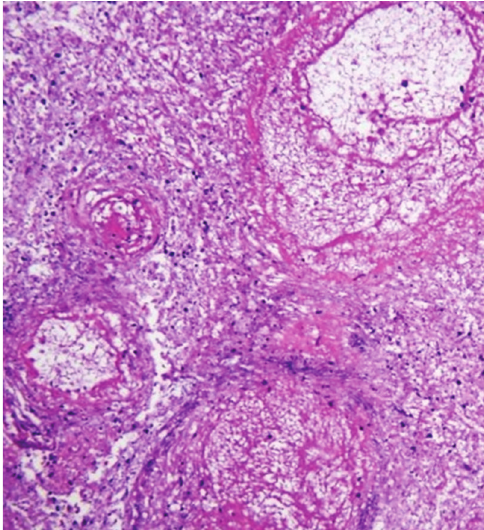
Figure 3: Corresponding histopathological section, stained with hematoxylin and eosin, showing hemorrhagic necrosis rich in altered polynuclear